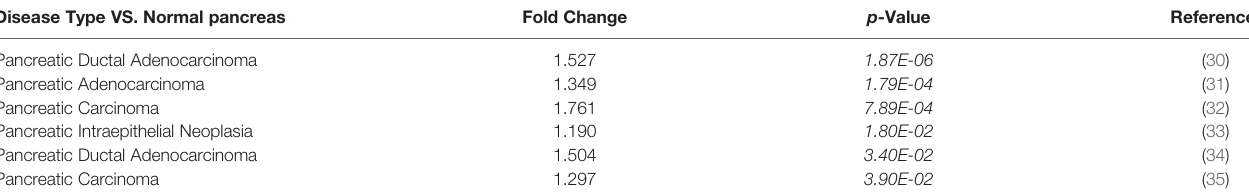
TABLE 1 | KPNA4 expression change between PDAC and normal pancreas tissues (Oncomine). Disease Type VS. Normal pancreas Fold